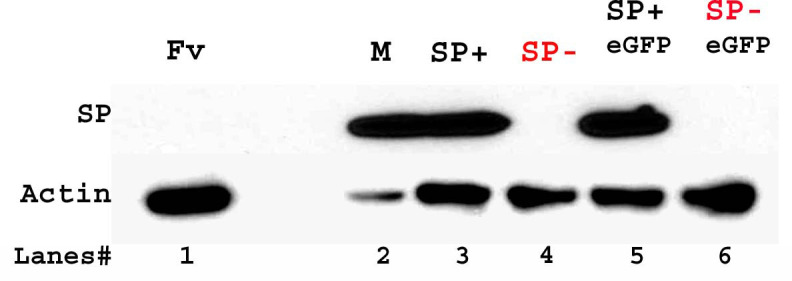
Western blot probed for SP.Lanes/samples are 1: Fv, reproductive tract (RT) of three virgin females (negative control); 2: M, one pair of male accessory glands (positive control); 3: SP+, RT of three females mated to control (TM3 siblings of SP-null males; positive control) males at 2 hr ASM; 4: SP-, RT of three females mated to SP-null males at 2 hr ASM; 5: SP+ eGFP, RT of three females mated to control (TM3 siblings of SP-null; ProtB-eGFP males; positive control) males at 2 hr ASM; 6: SP- eGFP, RT of three females mated to SP-null; ProtB-eGFP males at 2 hr ASM. Actin served as loading control.